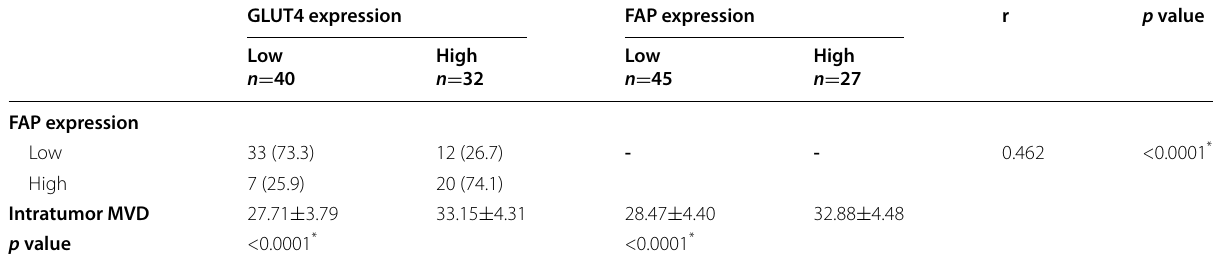
MVD microvessel density, r Spearman’s correlation, * p <